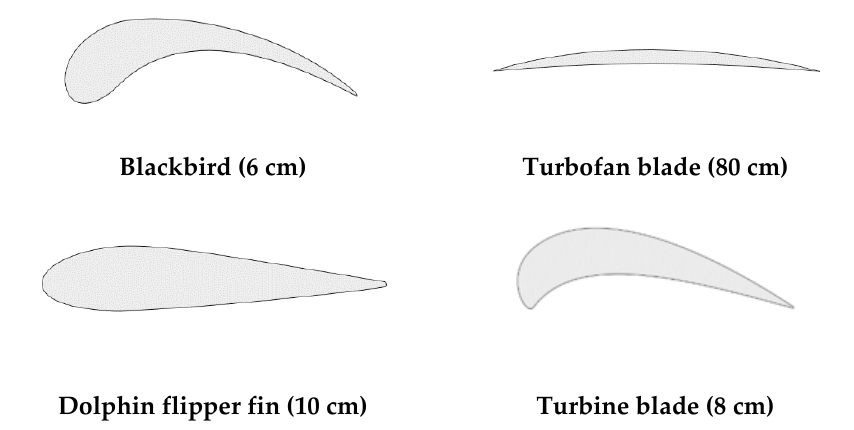
Figure 3. Various airfoil shapes [22–29].